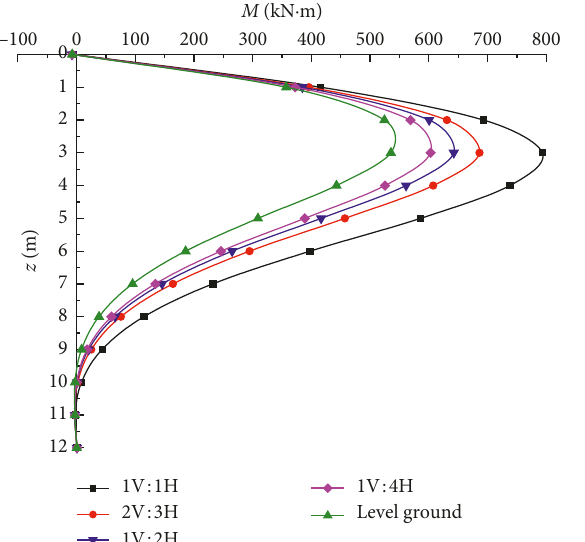
Figure 11: Effect of slope ratio on maximum bending moment.